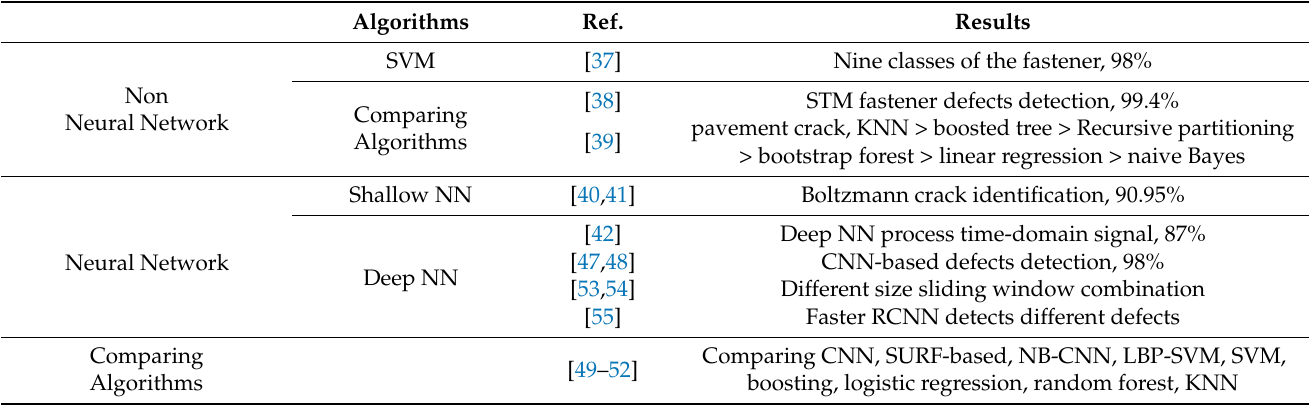
Figure 2. Overall architecture of AlexNet. Reprinted from Ref. [53] with permission of Sensors, 2018. Table 2. Summary of object